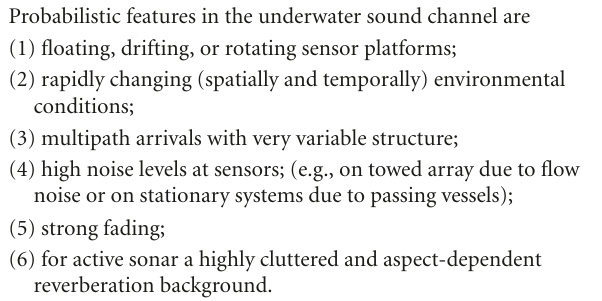
Table 1: Probabilistic features in the underwater sound channel. Probabilistic features in the underwater sound channel